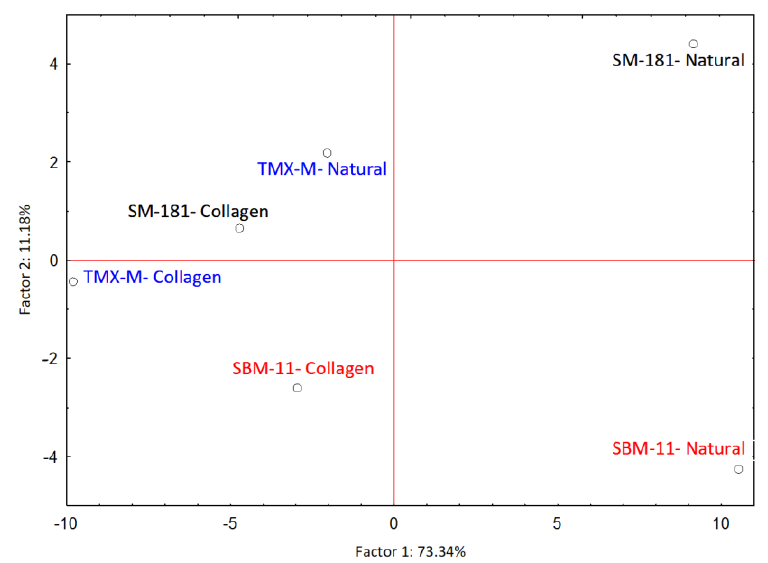
Figure 3. PCA case coordinates for the first two factors explaining the influence of adopted casing and starter cultures on the final aroma profile of fermented sausages. and starter cultures on the final aroma profile of fermented